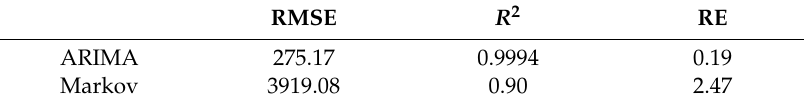
Table 7. Prediction error of the training set at monitoring point 1.